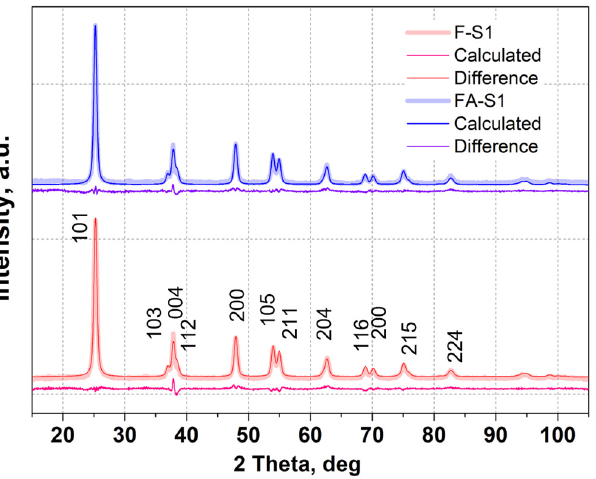
Figure 3. X-ray diffraction patterns of the samples F-S1 and FA-S1 with Rietveld refinement. For samples of the CR2 series calcined at 300 ◦ C, the diffraction lines are much wider,